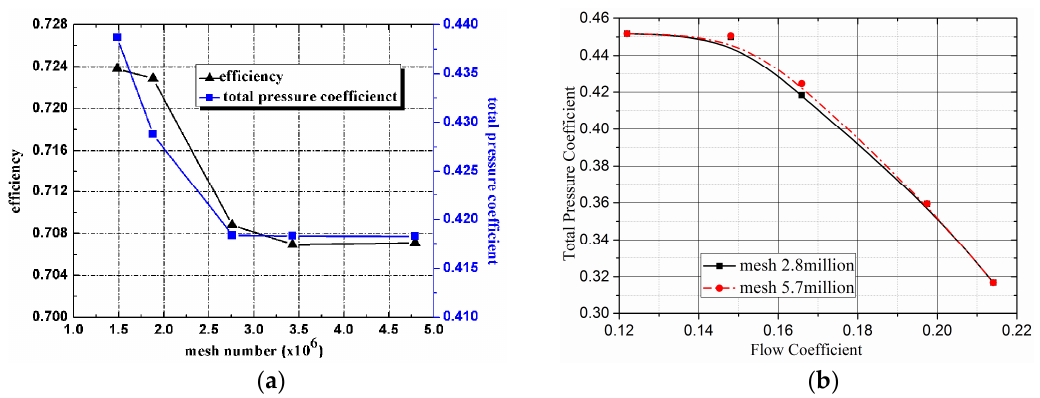
Figure 3. Gridsize independent: ( a ) fan total pressure and efficiency with grid size; ( b ) total pressure coefficient with flow rate.